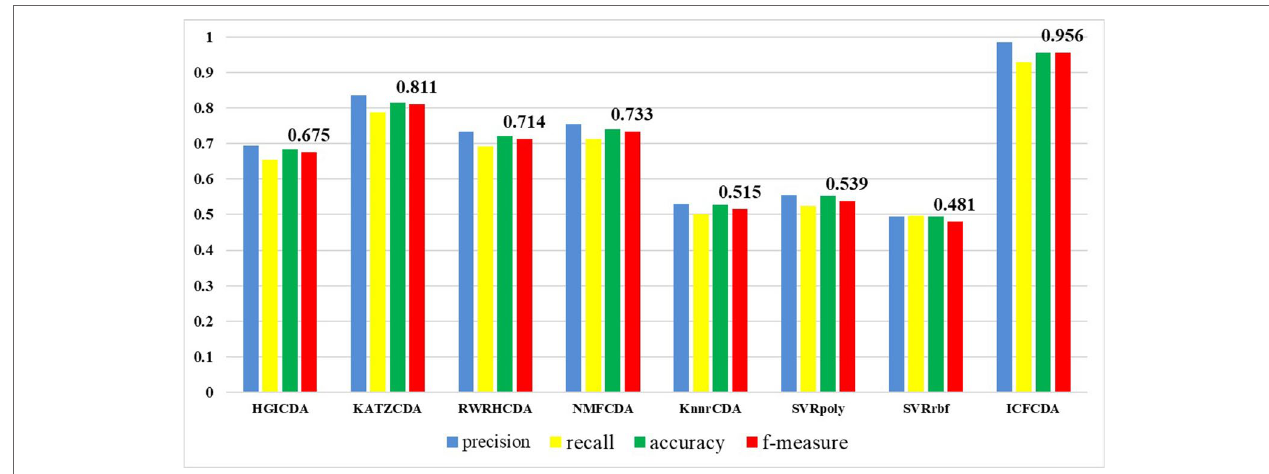
FIGURE 5 | Comparison of the precision, recall, accuracy, and f -measure with different methods.